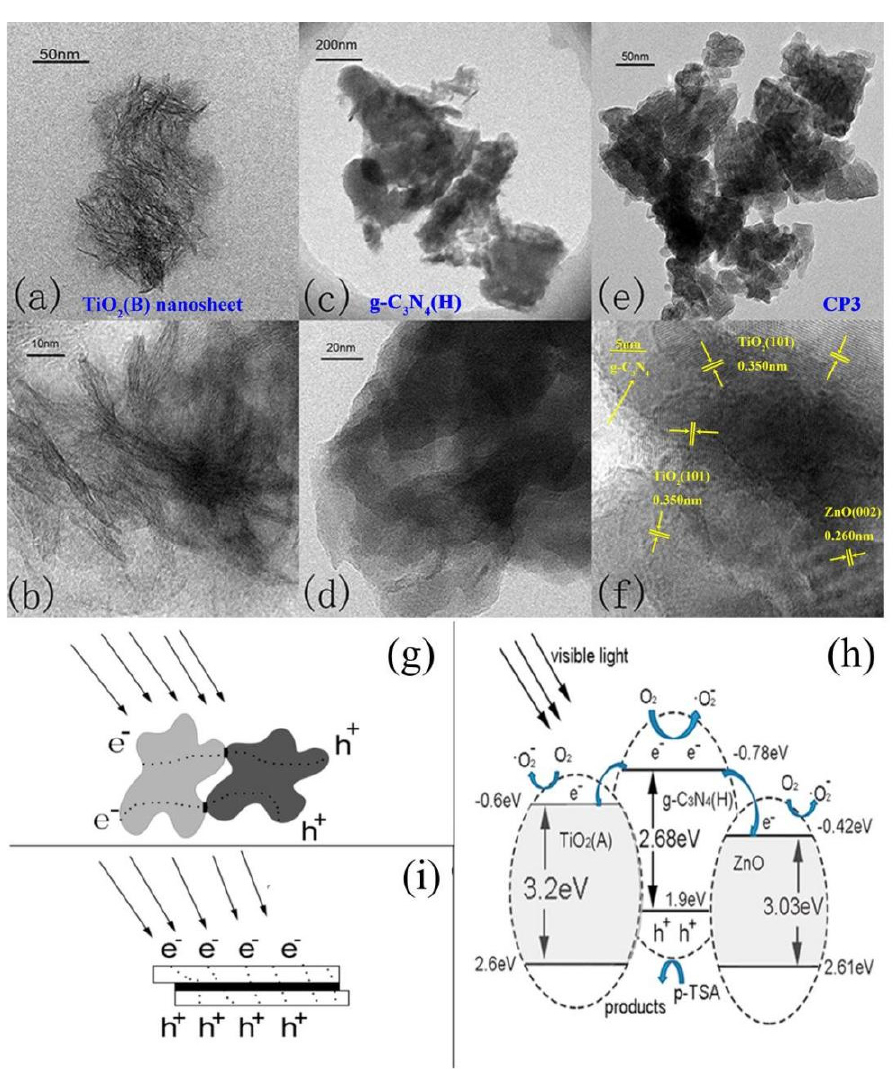
Figure 11. TEM images of ( a , b ) TiO 2 nanosheets, ( c , d ) g − C 3 N 4 nanosheets and ( e , f ) g − C 3 N 4 /TiO 2 /ZnO nanocomposites; ( g , i ) comparison of the electron transfer routes between the granule/granule and the nanosheet/nanosheet composites with different heterojunction areas; ( h ) the mechanism of facet − coupled ternary nanocomposites for p − TSA degradation under visible light. Used with permission from [138]. Copyright 2017 Elsevier.